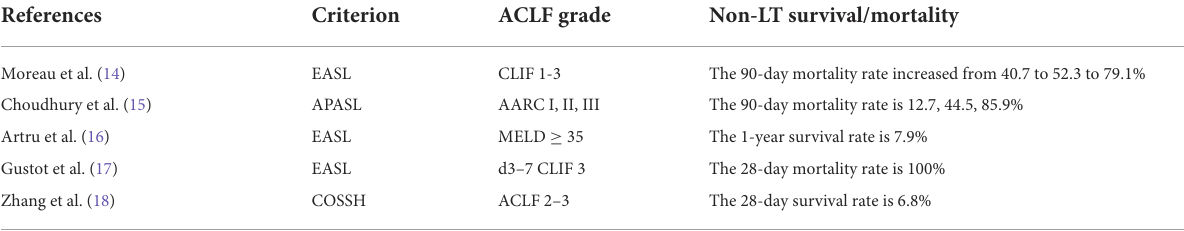
TABLE 1 Non-transplantation-related outcomes in part of studies of Acute-on-Chronic liver failure (ACLF).